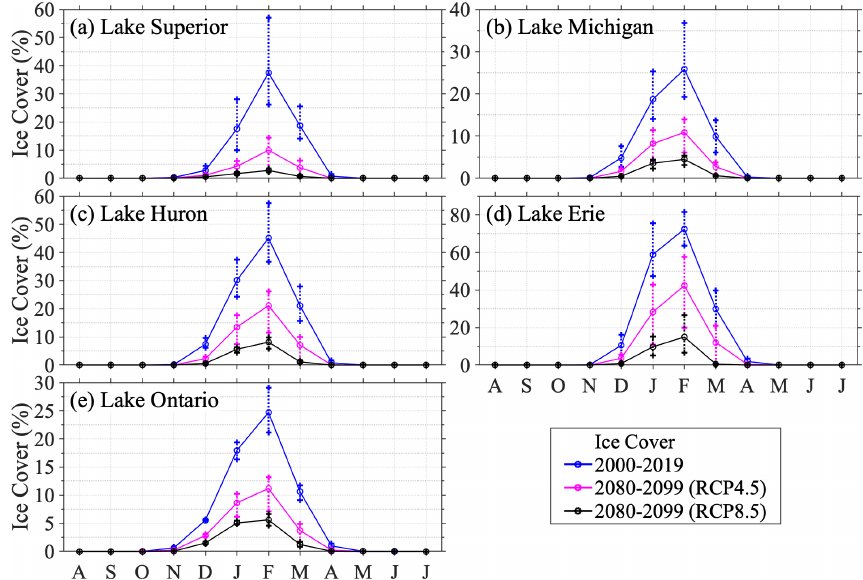
Figure 13. Projected monthly ice cover in the five lakes in the late century (2080–2099) in RCP 4.5 (pink) and RCP 8.5 (black) in comparison to the present-day conditions (2000–2019) (blue). Vertical error bars indicate the range of the three individual GLARM projections.